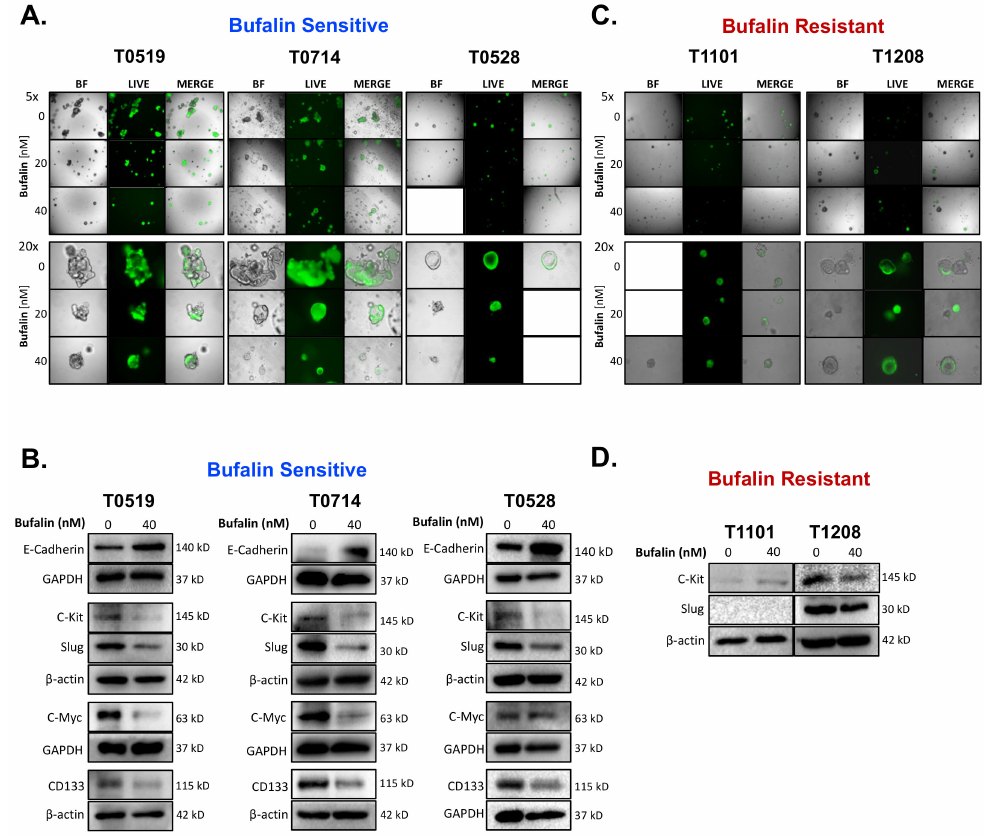
Figure 6. Bufalin-sensitive CRC PDOs are characterized by strong inhibition of C-Kit/Slug, restora- tion of E-cadherin, and decreases in CD133 and C-Myc expression. ( A ) Representative images of Calcein-AM staining of T0519, T0528, and T0714 at the termination of bufalin treatment, confirming the decrease in live PDOs at 20 and 40 nM concentrations. ( B ) Immunoblotting of PDO lysates demon- strating a strong decrease in the expression of both mechanistic targets C-Kit and Slug, decreased expression of CSC markers CD133 and C-Myc, and upregulation of epithelial marker E-Cadherin following 48 h of treatment with 40 nM of bufalin compared to vehicle control in PDOs sensitive to bufalin T0519, T0528 and T0714. ( C ) Representative images of Calcein-AM staining of T1208 and T1101 that confirm that there are no significant changes in the number or size of live PDOs at the end point of bufalin treatment. ( D ) Immunoblotting of PDO lysates demonstrating little or no effect on C-Kit and/or Slug protein expression after 48 h of treatment with 40 nM bufalin compared to vehicle control in bufalin-resistant PDOs T1208 and 1101. (A-C Images: Top panels: 5 × magnification; Bottom panels: 20 ×